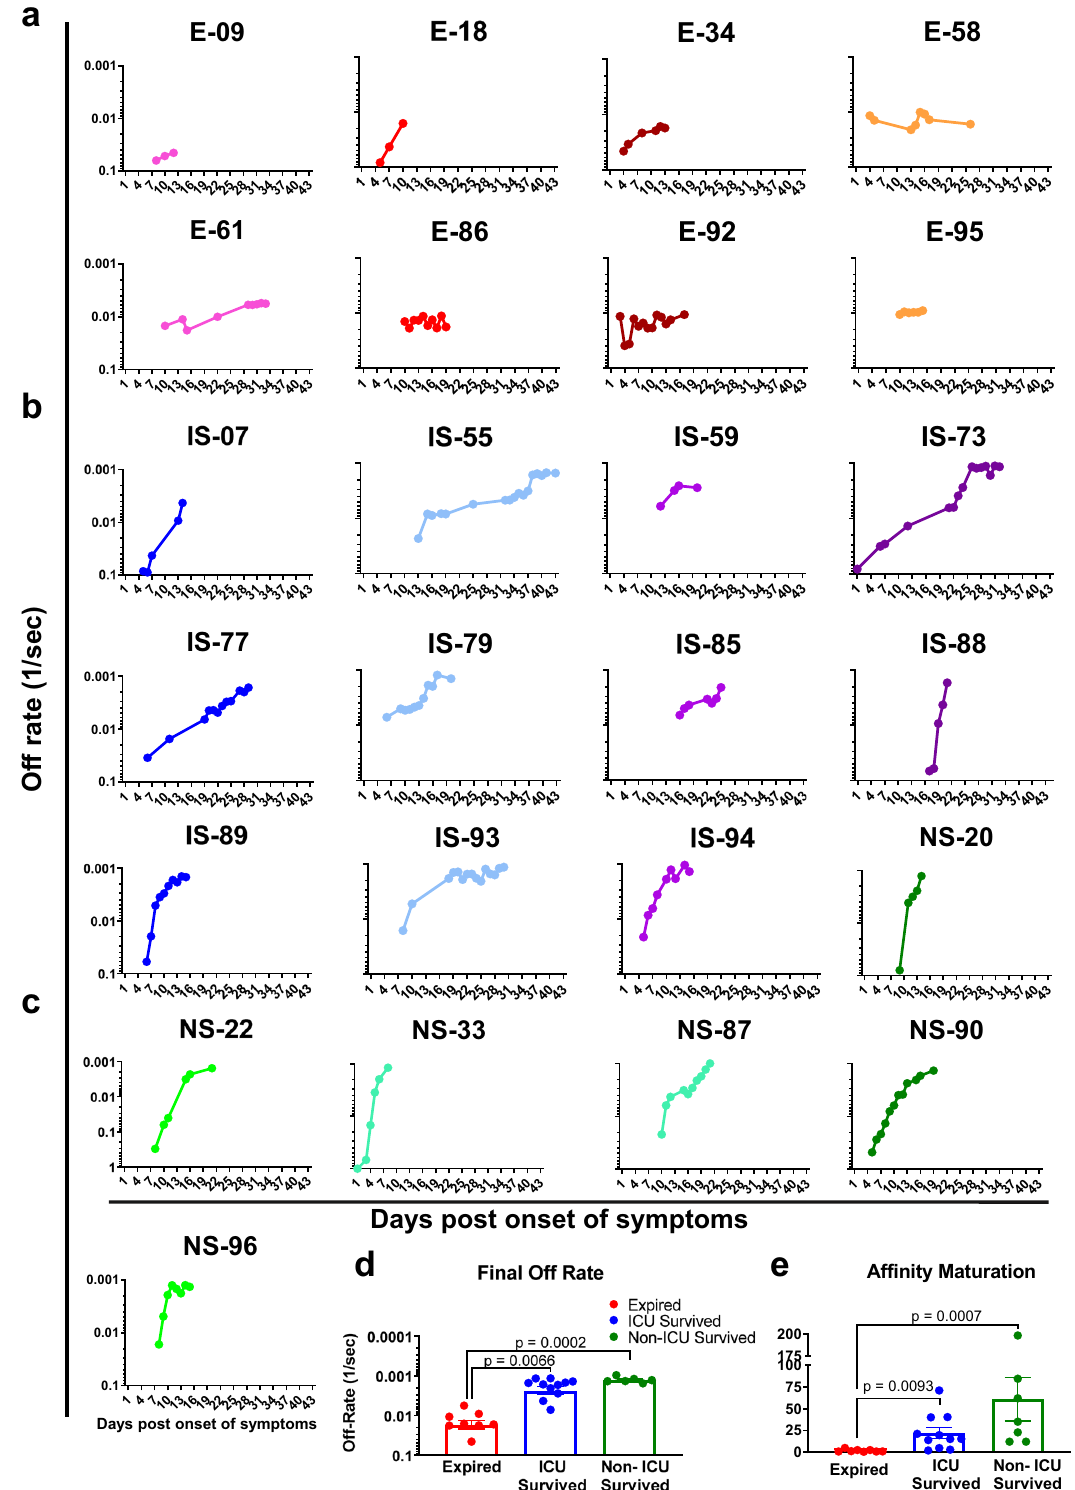
antibody af fi nity against ZIKV E-DIII correlated with lower clinical scores 21 . A recent longitudinal study of af fi nity matura- tion in a survivor of Ebola virus showed that increased af fi nity to Ebola virus GP was associated with a rapid decline in viral replication and illness severity in this patient 20 . Thus, the ability of virus-speci fi c B cells to enter germinal centres (GC) in lymph nodes and undergo af fi nity maturation may have consequence on